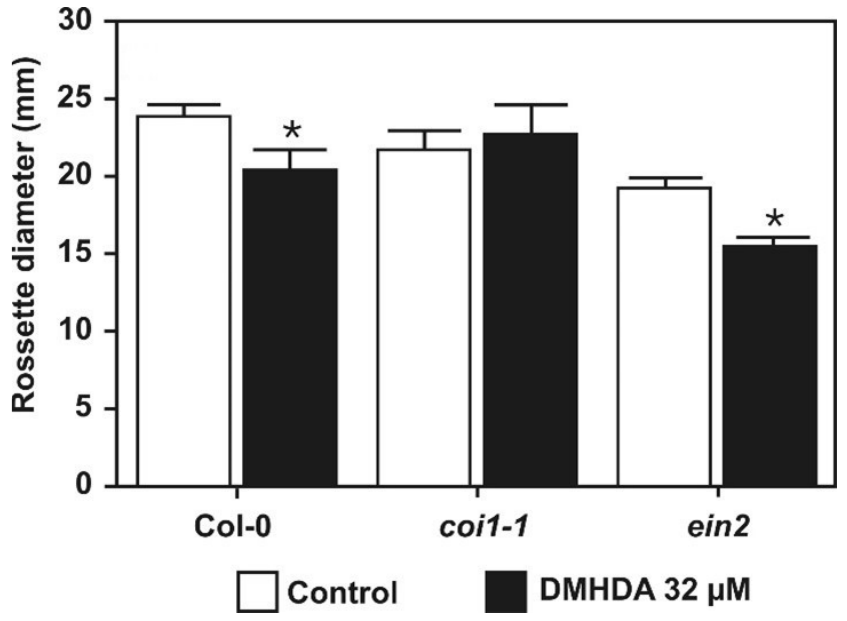
Figure 3. Role of COI1 and EIN2 genetic elements in the growth of A. thaliana in response to DMHDA. Ten days after germination on the Petri dish, seedlings of Col-0, coi1-1, and ein2 were transferred to flasks with 0.2× MS medium supplied with 0 (solvent; Control) and 32 µM of DMHDA. Eight days after transfer, rosette diameter was recorded. Values represent the means of 40 ± SE. Asterisks (*) represent statistically significant differences in rosette diameter compared with the control condition (Student t-test; p < 0.05).